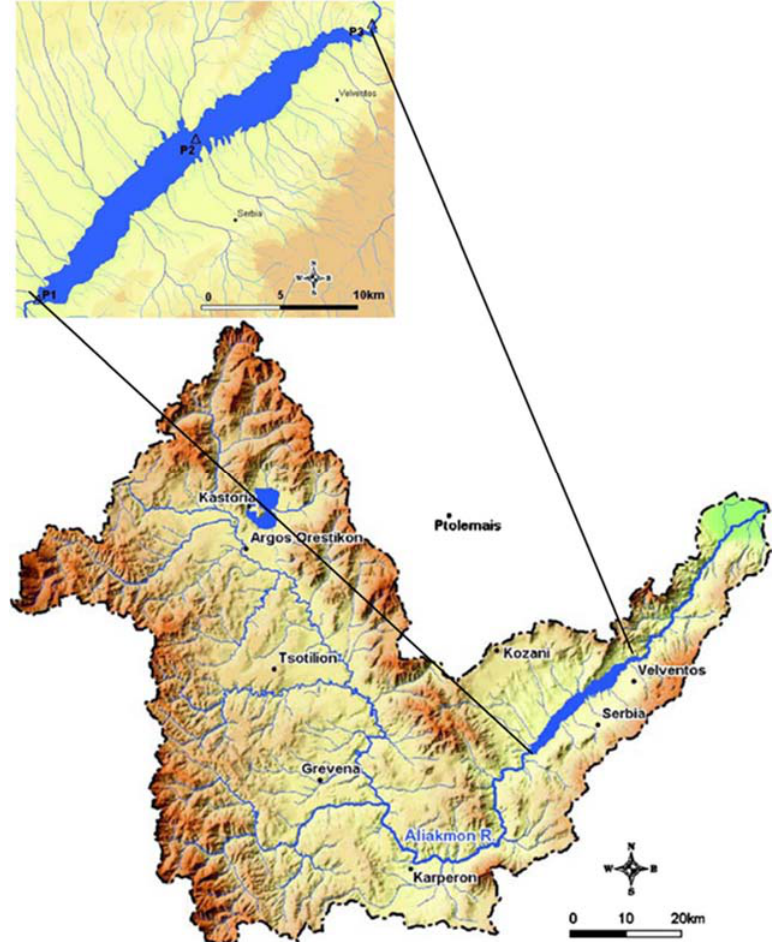
Figure 1. Morphology of Aliakmon River Basin and positions of the monitoring stations P1, P2 and P3 in Polyphytos